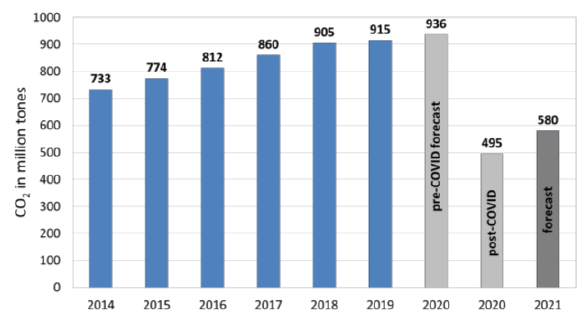
Fig. 3. CO 2 emission generated by the global commercial airlines [29,